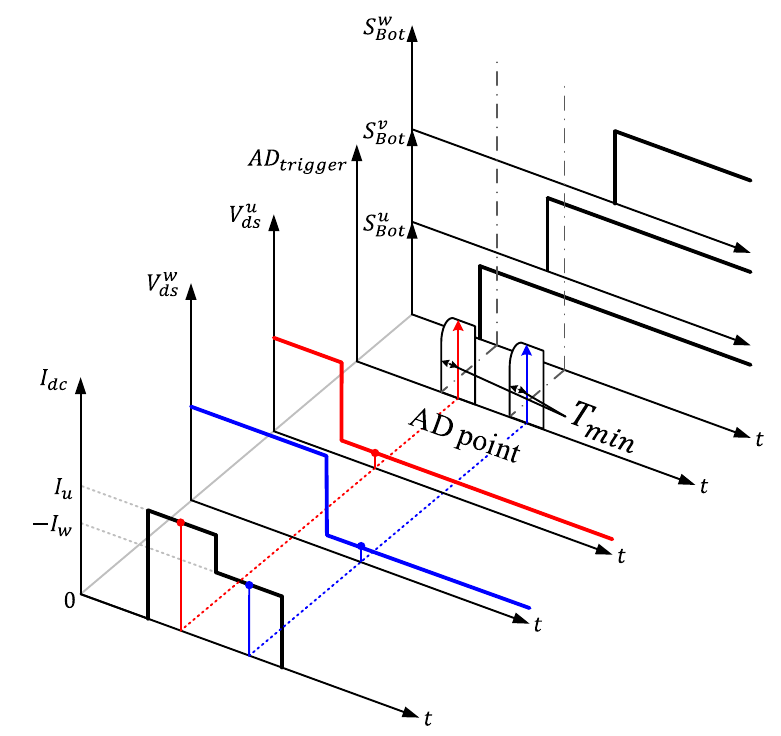
Figure 1. Synchronization of the V ds , I dc measurement when switch at the bottom of the MOSFET is on.